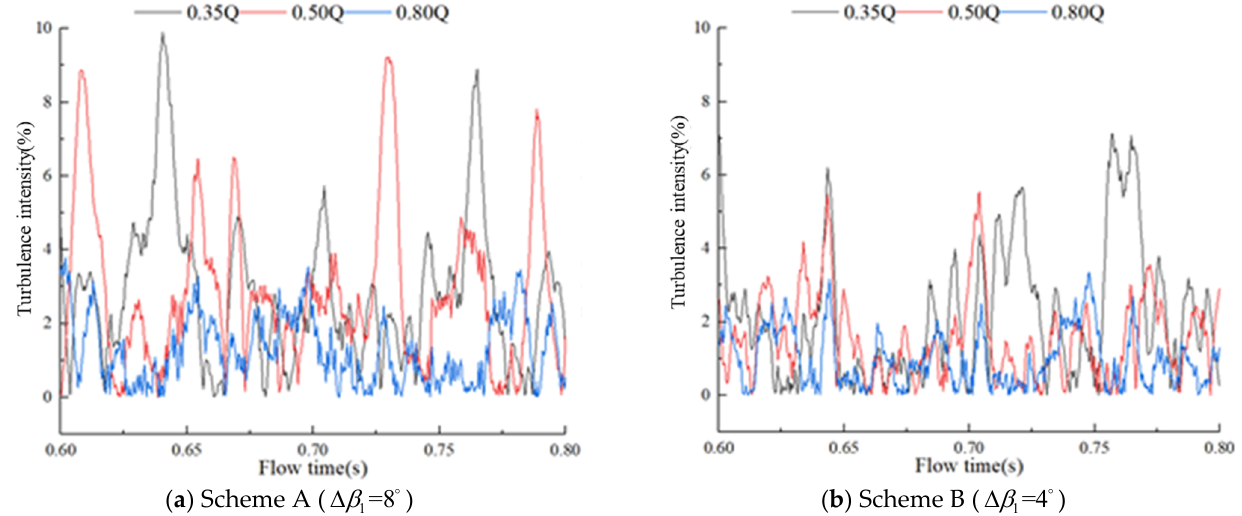
Figure 12. Turbulence intensity of monitoring point I1 at the inlet of impeller.